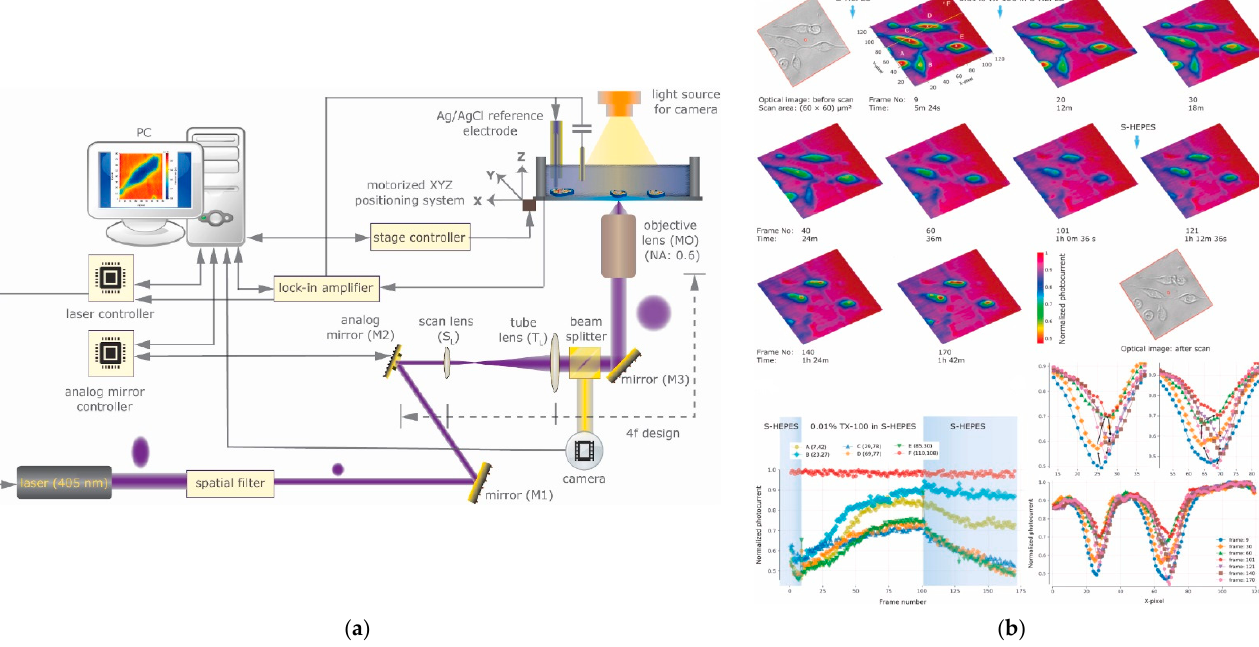
Figure 7. ( a ) Schematic of the photoelectrochemical imaging setup with an analog micro-mirror-based fast beam steering was achieved with 4f design lens relay system. ( b ) Photocurrent changes under cells during exposure to a TX-100 concentration smaller than the critical micelle concentration. Including time-lapse photocurrent images of B50 cells exposed to 0.01% TX-100 in S-HEPES buffer, time-dependent photocurrent traces for individual cells and photocurrent X -axis line scan analysis [115]. Table 5. Targets, main improvements, technology, detection limits or ranges, noise and measure- ment times of articles on the improvement of LAPS optical systems published in recent years.